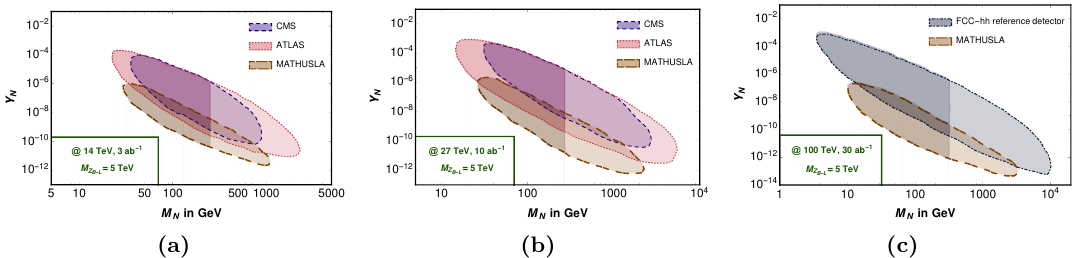
Figure 14. Limits obtained via the displaced decays of RHNs to 2 ‘ + 2 j final state (dark shaded region), 2 ‘ + 4 j final state (light shaded region) and it is presented in Y 95% CL, where M is 5 TeV. The probable regions are for different centre of mass energies, i.e. Z B − L 14 TeV, 27 TeV and 100 TeV at the integrated luminosities of 3, 10 and 30 ab − 1 , respectively. The purple, pink, grey and light brown colours depict the reaches for CMS, ATLAS, FCC-hh reference detector and MATHUSLA,